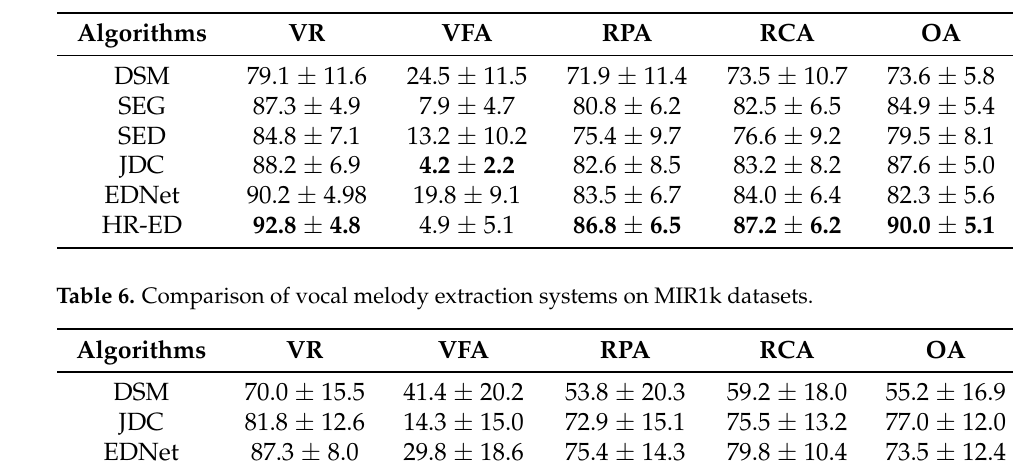
Table 5. Comparison of vocal melody extraction systems on MIREX05 datasets.